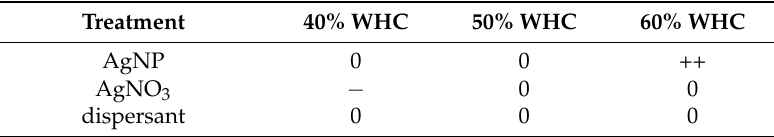
Table 2. Summary of the effects of AgNP, AgNO 3 , and dispersant on F. candida reproduction with different soil water contents in the tested concentration range. ++ = strong increase, 0 = no difference, − =